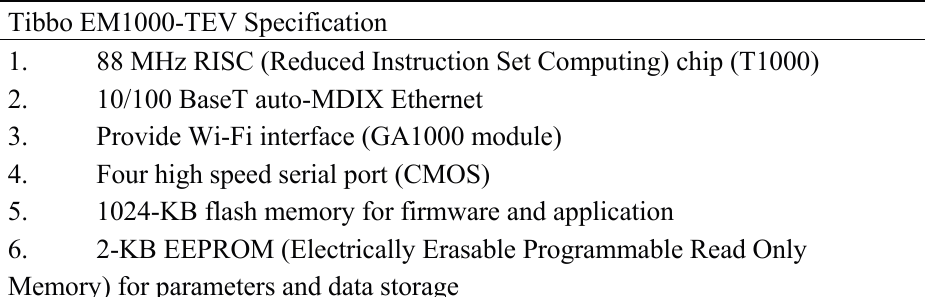
Table 2. Tibbo EM1000-TEV hardware